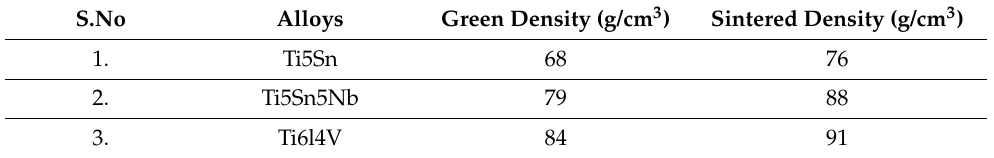
Table 5. Green and sintered densities of the alloys.